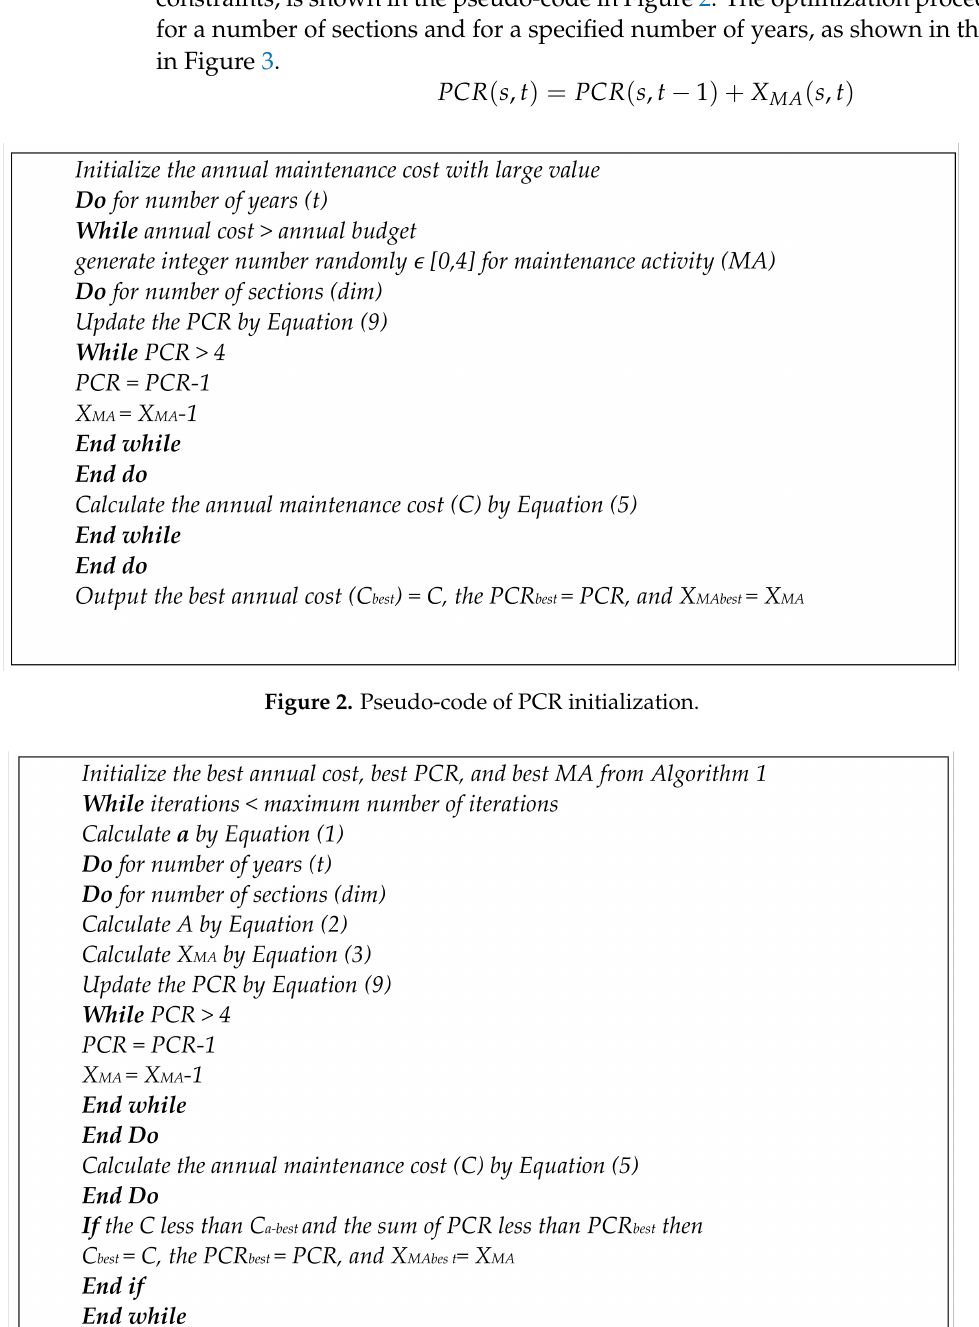
Figure 3. Pseudo-code of the application of the ISA algorithm for PMMS